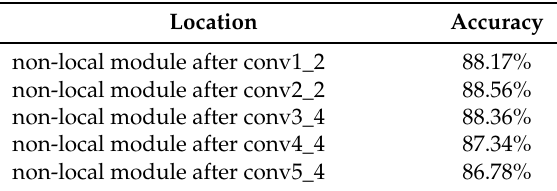
Table 2. Performance comparison of inserting non-locally enhanced modules at different locations of feature extractor.